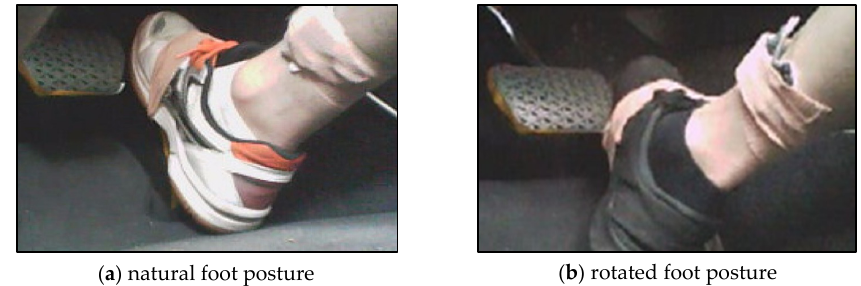
Figure 1. Illustration of foot postures to operate the organ-type accelerator